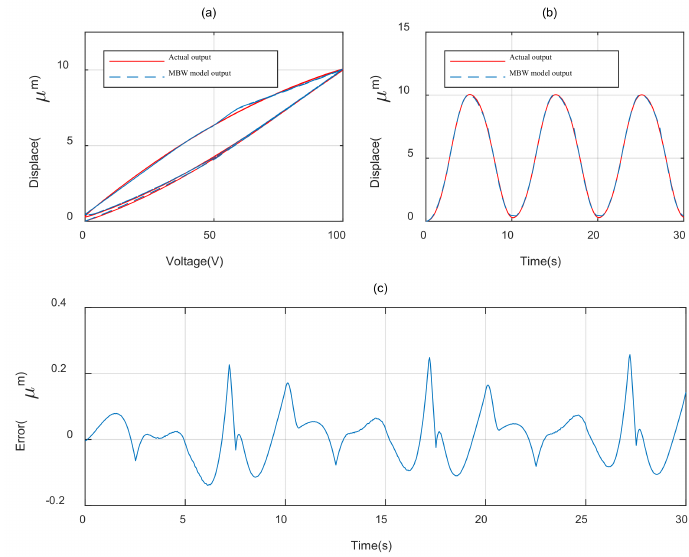
Figure 8. Modeling result of MBW model. ( a ) Hysteresis loop. ( b ) Displacement curve. ( c ) Error